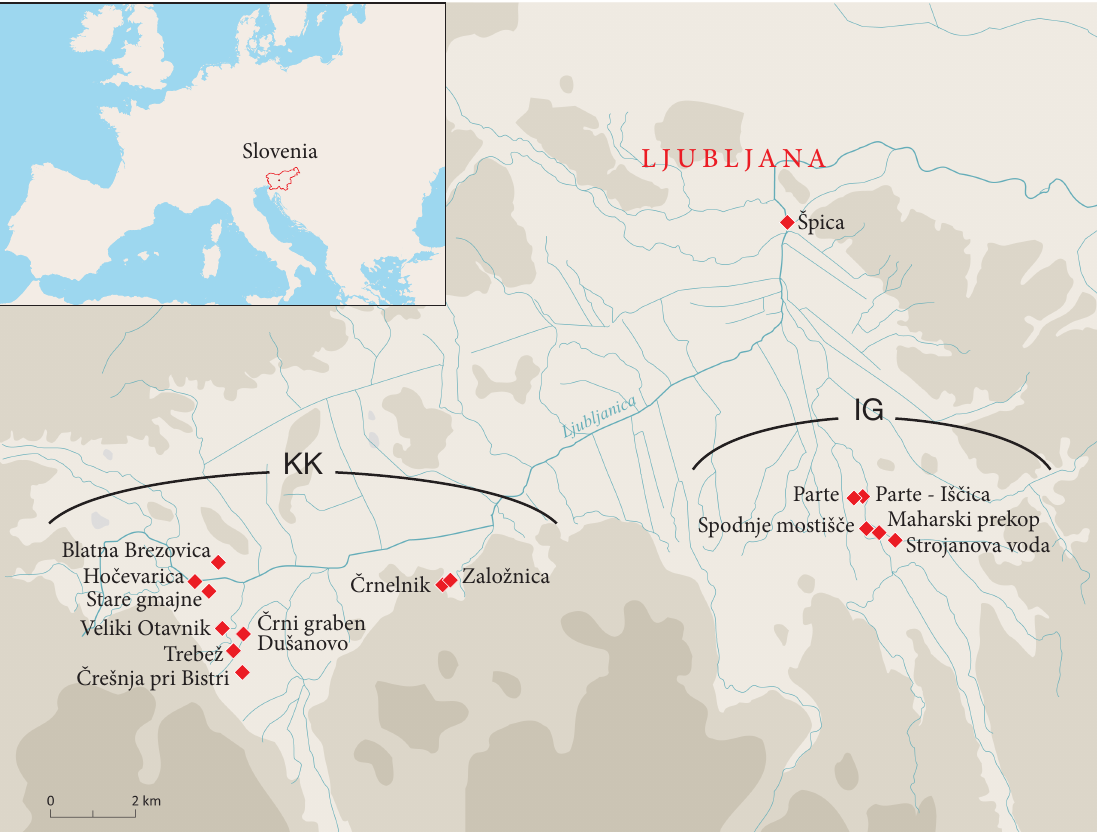
Figure 1. Ljubljansko barje, Slovenia, located southeast of the Alps and directly south of the city of Ljubljana, with the locations of the 16 investigated Eneolithic pile dwellings. Geographical clusters: KK = Kamnik pod Krimom; IG = Ig. The sites ˇCrni graben and Dušanovo represent two excavations of what later has been interpreted as a single site, Dušanovo. After a figure by T. Korošec. Table 1. The studied sites with information about the number of posts, the quantity of posts of ash ( Fraxinus sp.) and oak ( Quercus sp.), and the excavation year. Cl. = geographical cluster, KK = Kamnik pod Krimom; IG = Ig; n = number. 9 (10) = 9 posts with age and diameter data; 10 posts in total of which there is one for which no diameter and/or age data are available. ˇCrni graben and Dušanovo represent two excavations of what has been later interpreted as a single site, Dušanovo.